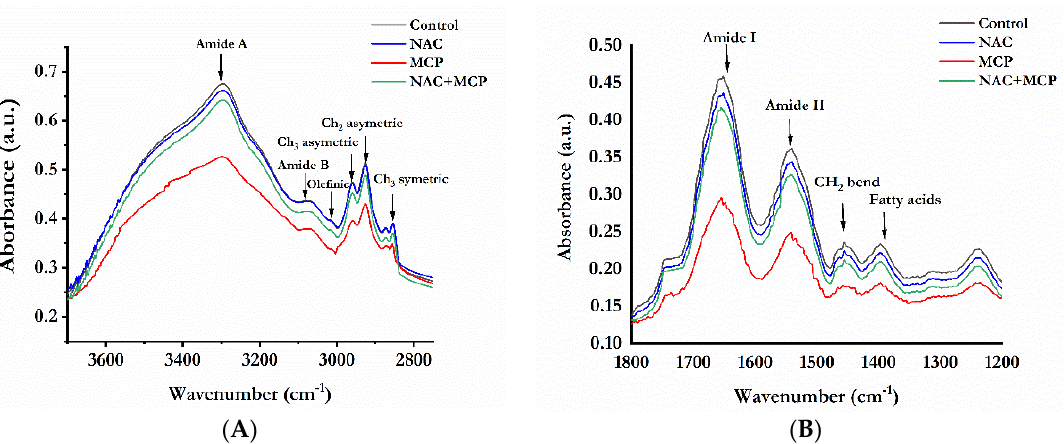
Figure 3. NAC pre-treatment restores MCP exposure-induced structural alterations in rat liver.The FTIR spectra are representing the selected wavenumber range of ( A ) region 3700 to 2750 cm −1 ; ( B ) region 1800 to 1200 cm −1 . The spectra are representative of N = 3. Table 3. Description of frequency assignment of FTIR spectra in rat liver.